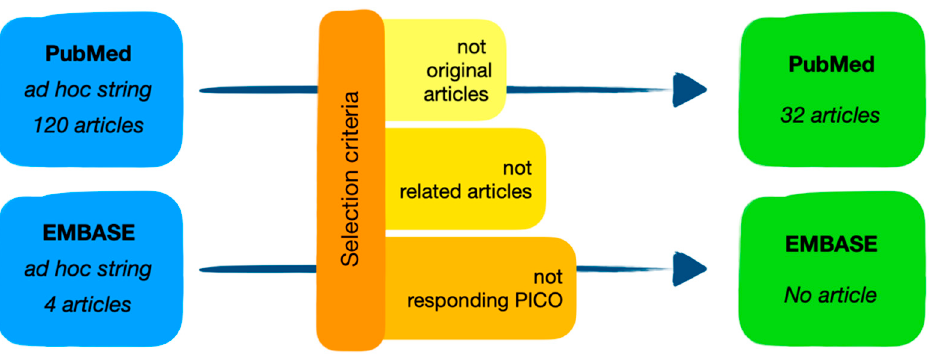
Figure 2. Research strategy flow-chart.